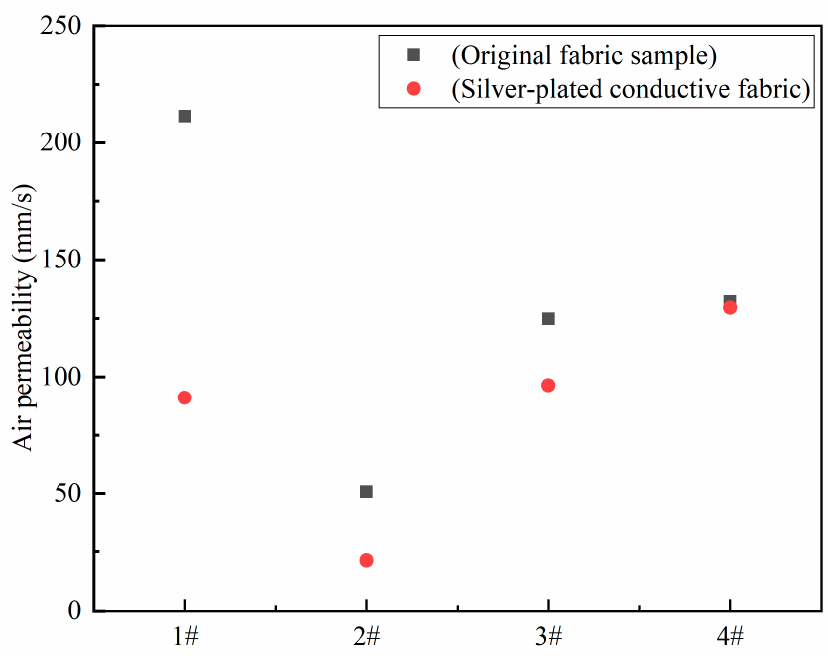
Figure 4. The original state of the four fabrics and the breathability test results of the silver-plated conductive fabrics.